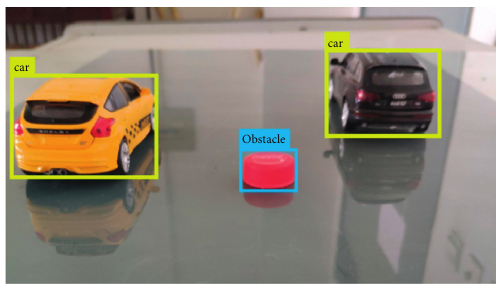
Figure 20: Improved VM identification effect diagram.